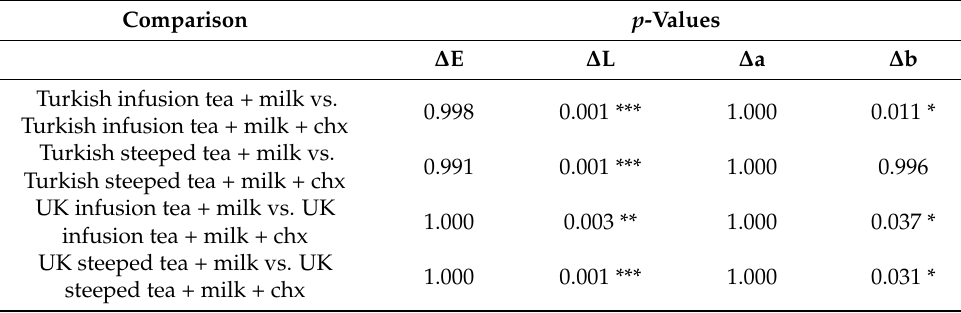
Table 2. Comparison of the milk tea solutions with and without chlorhexidine.